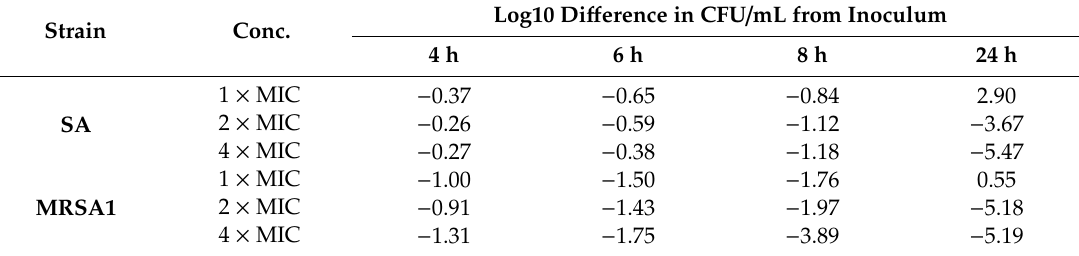
Table 6. Change in viable counts (log10 CFU / mL) of staphylococci strains following incubation for 24 h with vancomycin. Strain